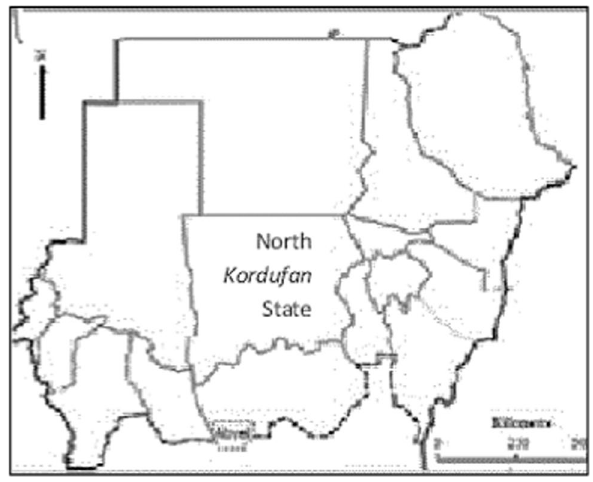
Fig. 1 North Kordofan state,